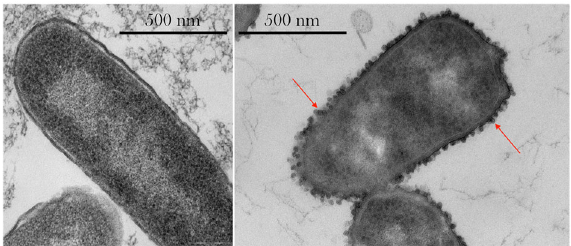
Fig. 7 Thin-section transmission electron microscopy images of E. coli . Left: Sample cultures on Earth. Right: Sample cultured in space exhibiting an irregular cell shape. Red arrows indicate extracellular vesicles. Images taken with a Phillips CM 100 TEM at an accelerating voltage of 80 kV. Figure and modi fi ed caption reprinted from Zea et al. 96 under the CC BY 4.0 License (https://creativecommons.org/